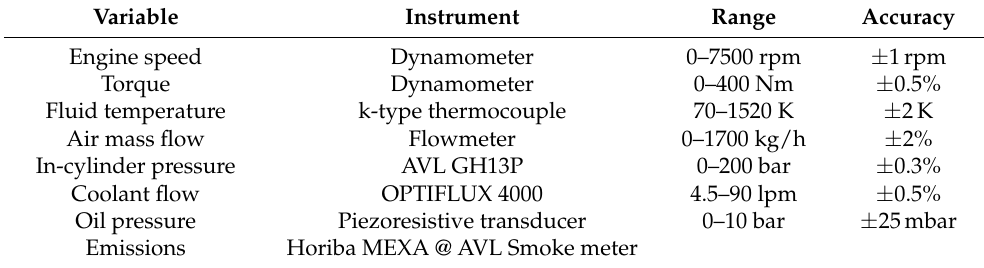
Table 2. Laboratory instrumentation.